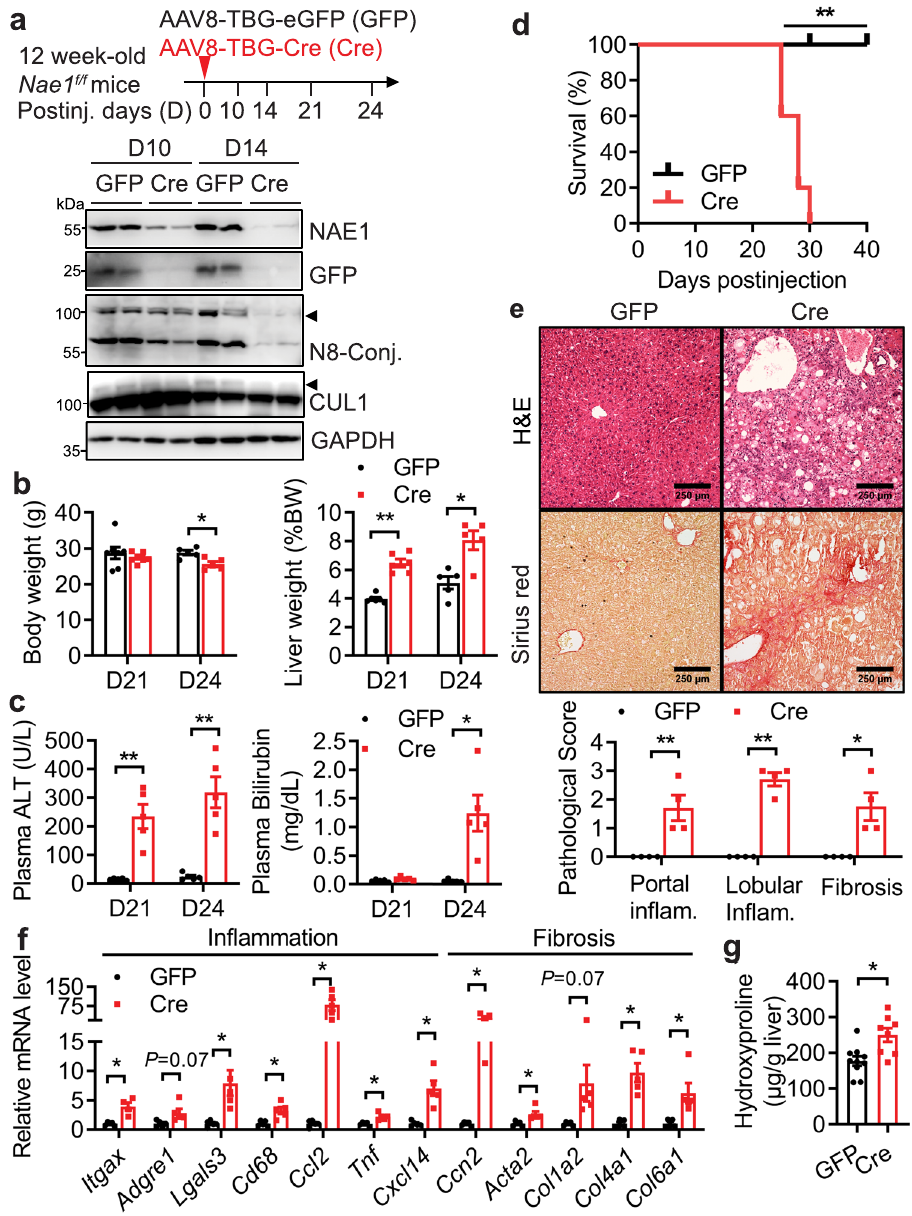
Fig. 2 | Adult-onset, hepatocyte-speci fi c deletion of NAE1 causes liver failure. a Schematic diagram depicting intravenous injection of AAV8-TBG-Cre (AAV-Cre, Cre) to 12-week-old Nae1 f/f mice to induce NAE1 deletion in mature hepatocytes. AAV8-TBG-eGFP served as a control (AAV-GFP, GFP). NAE1, GFP, and neddylated conjugates (N8-Conj.) were analyzed by Western blot in liver extracts of GFP and Cre mice at D10 and D14 post-virus injections. Arrowheads indicate neddylated CULs and CUL1. Representatives of three independent experiments were shown. b BW and liver weight normalized to BW of GFP and Cre mice at D21 ( n =6 per group) and D24 ( n =5 pergroup). c Plasma ALT and bilirubinlevels of GFPand Cre miceatD21andD24post-virusinjections( n =5).Unpaired t -tests,two-tailedin b , c . P <0.05, ** P <0.005. d Survival curves (GFP: n =6; Cre: n =5). Log-rank